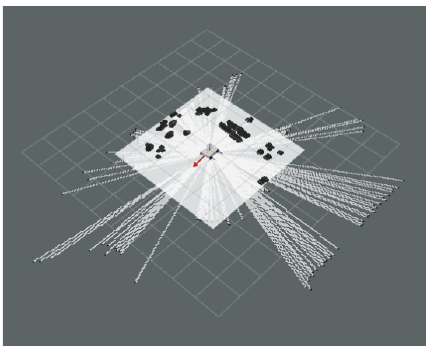
Figure 7: A local environment map.